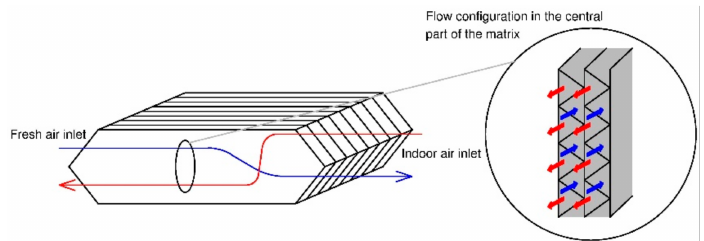
Figure 9. The exchanger of several corrugated plates in synthetic material